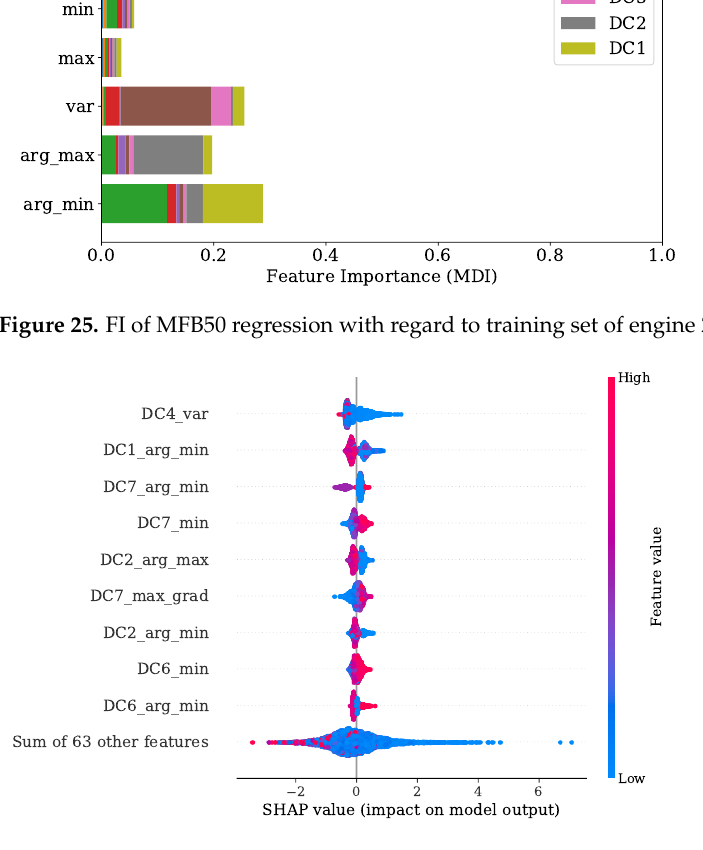
Figure 26. SHAP values summary of MFB50 regression with regard to training set of engine